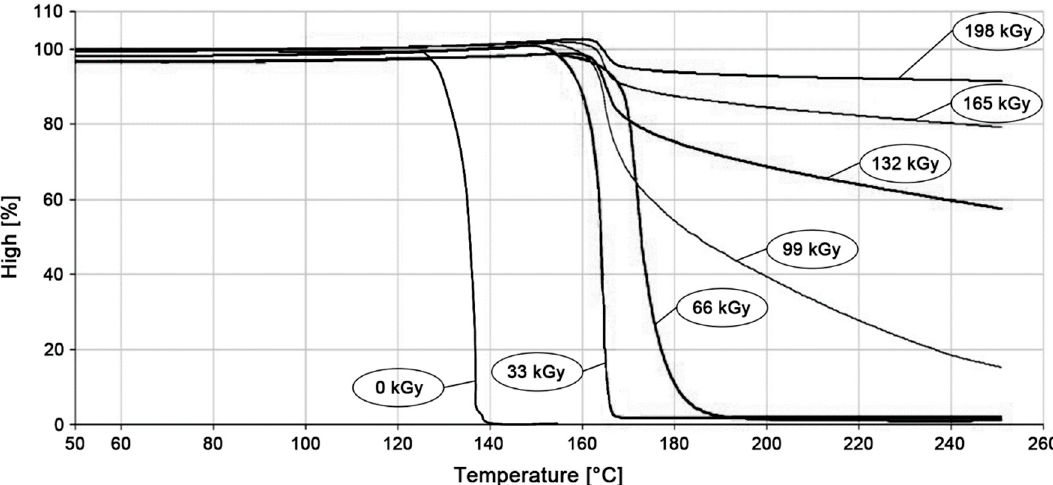
Figure 9. Graphic record of thermo-mechanical analysis.